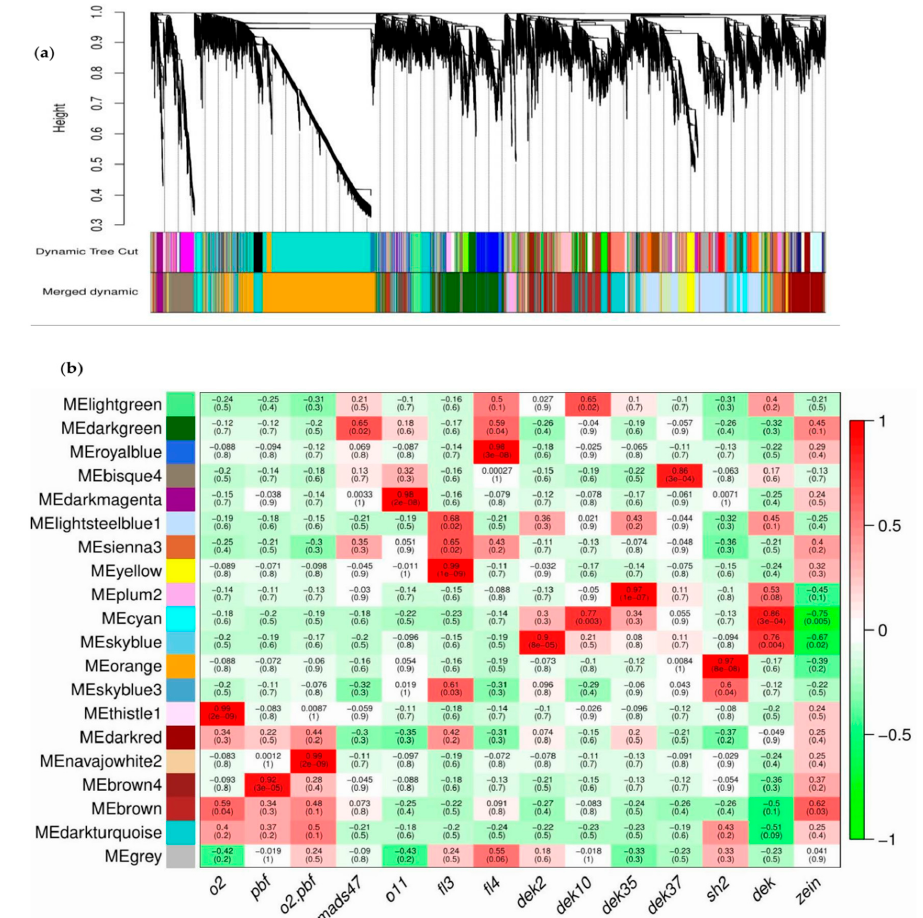
Figure 6. WGCNA using RNA-seq data for 12 endosperm mutants. ( a ) Hierarchical cluster analysis showing the co-expression modules identified by WGCNA; ( b ) Module–trait associations. Each row corresponds to a module. Each column shows one mutant ( dek represents the four dek mutants used in this study, similarly zein stands for the seven zein mutants. The values in each cell represent the corresponding correlation coefficient and p -value.